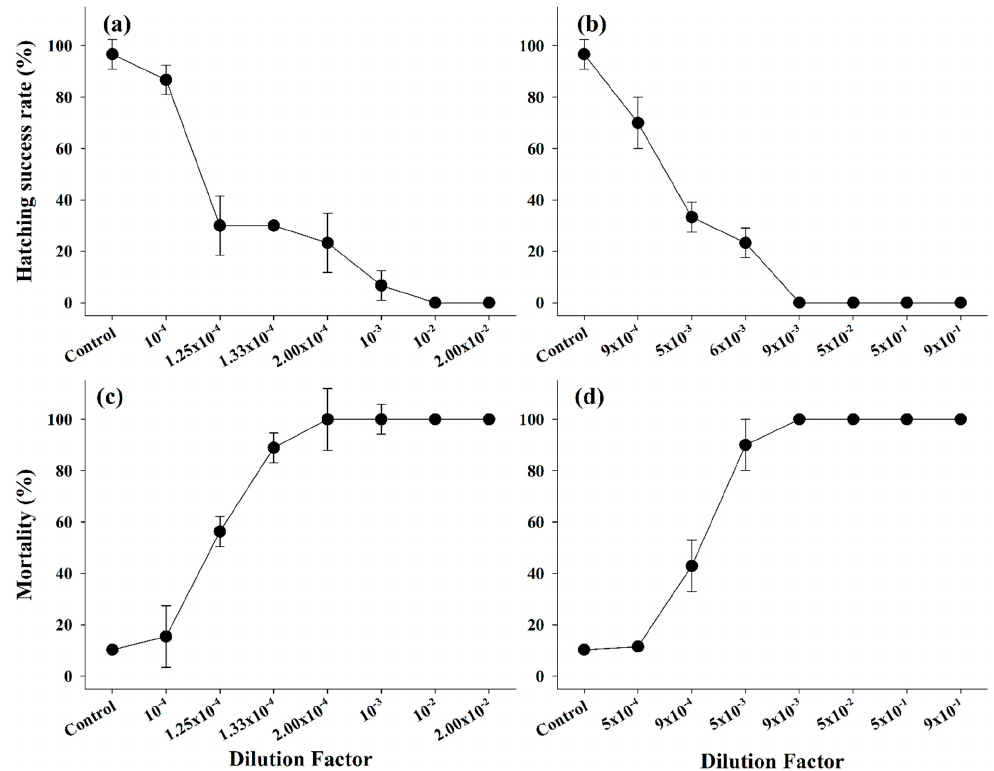
Figure 2. Egg-hatching success rate and nauplius mortality of Paracalanus parvus sl for wastewater (( a , c ): WHPB; ( b , d ): WHPB-MeOH) from high-pressure water blasting.